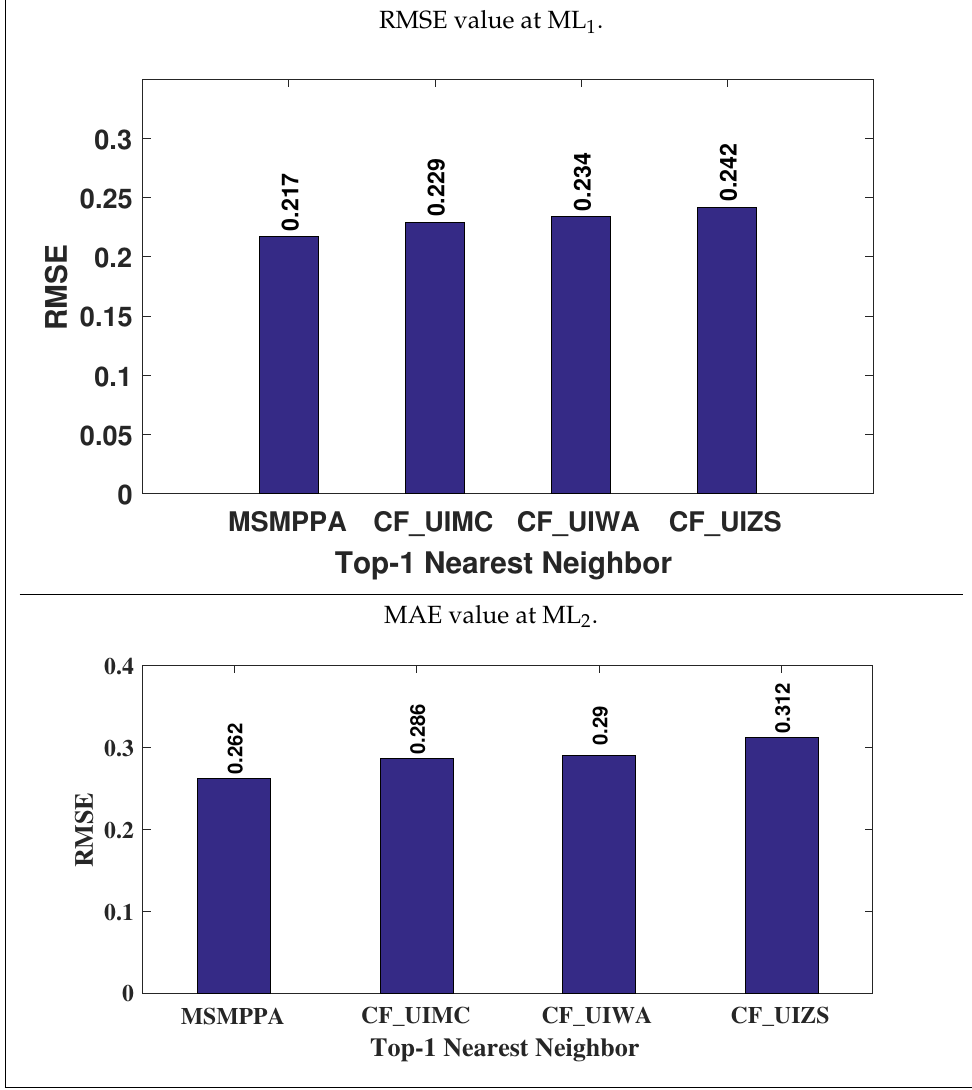
Figure 16. RMSE Value at